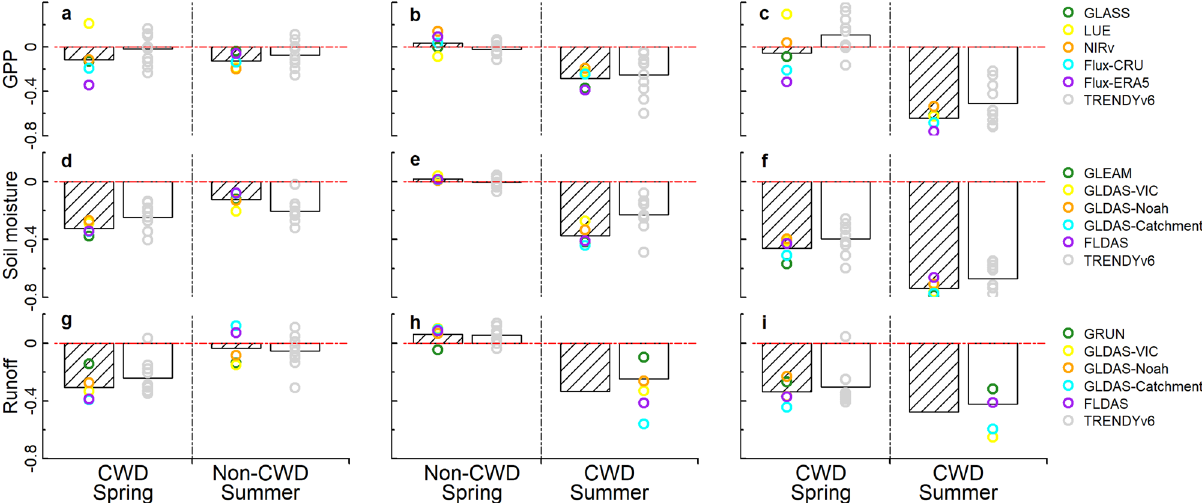
Fig. 4 The responses of vegetation productivity and hydrological variables to CWD events in mid-latitudes (23.5 – 50°N/S). a – c The average standardized anomalies (z-score) of GPP during CWD spring but subsequent non-CWD summer ( a ), non-CWD spring but subsequent CWD summer ( b ), and consecutive CWD spring and summer ( c ) for areas in Fig. 2a where summer vegetation responds negatively ( r ≤ − 0.22) to spring CWD climate conditions. d – f The same as a – c , but for soil moisture. g – i The same as a – c , but for runoff. The bar plots with dash lines (without dash line) indicate the average anomalies of multiple observation-based (model-based) products, and the circles indicate the average anomalies of each product. For details on data see Fig. 3.